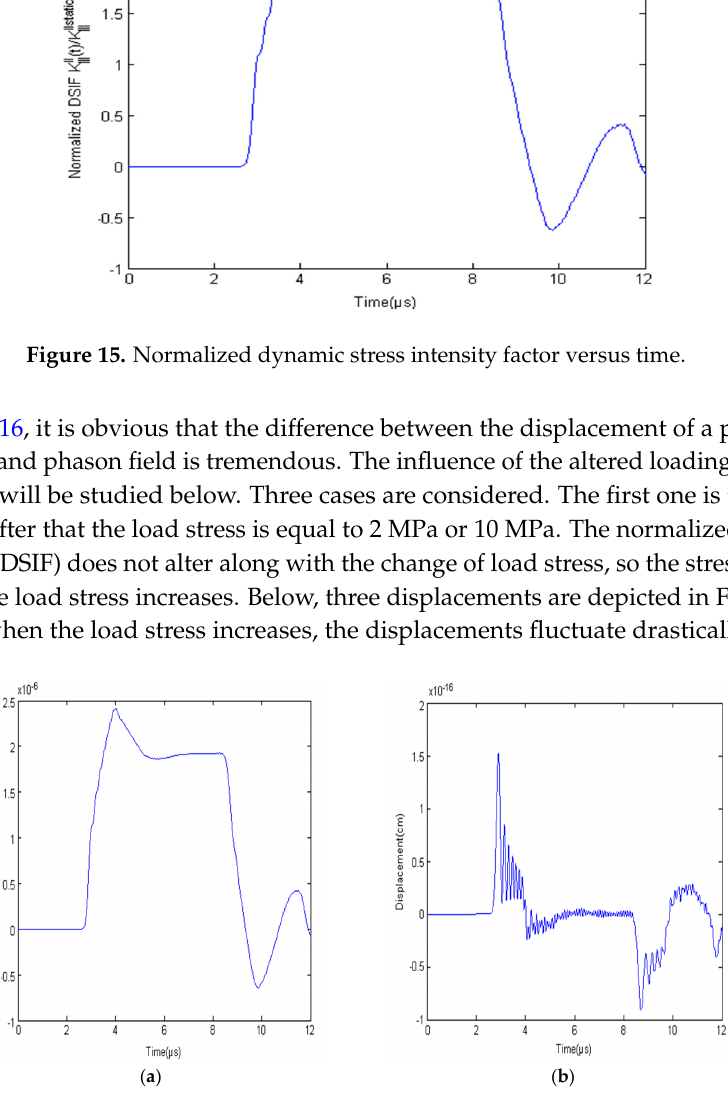
Figure 16. The displacement of a point at the crack tip of phonon field ( a ) and phason field ( b ).